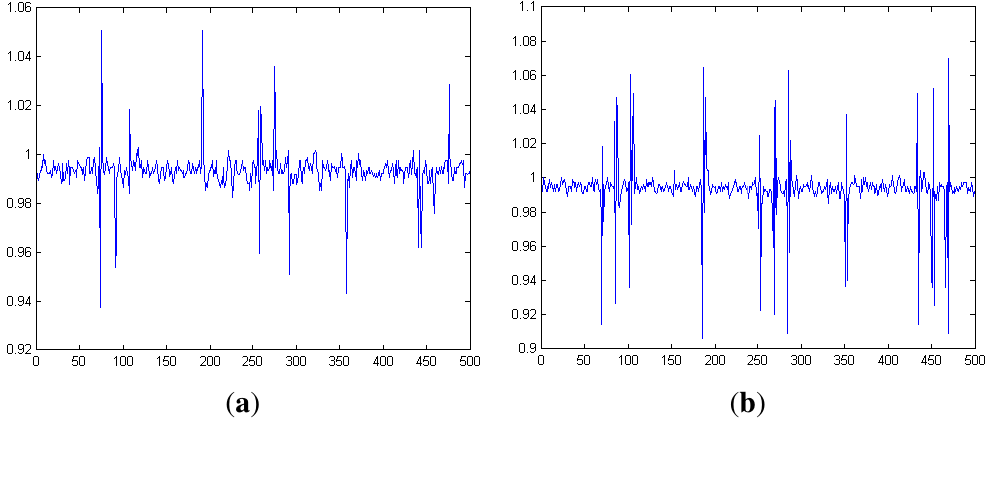
Figure 6. Normalized acceleration readings when the same vibration signal is transmitted with different vibration impulse